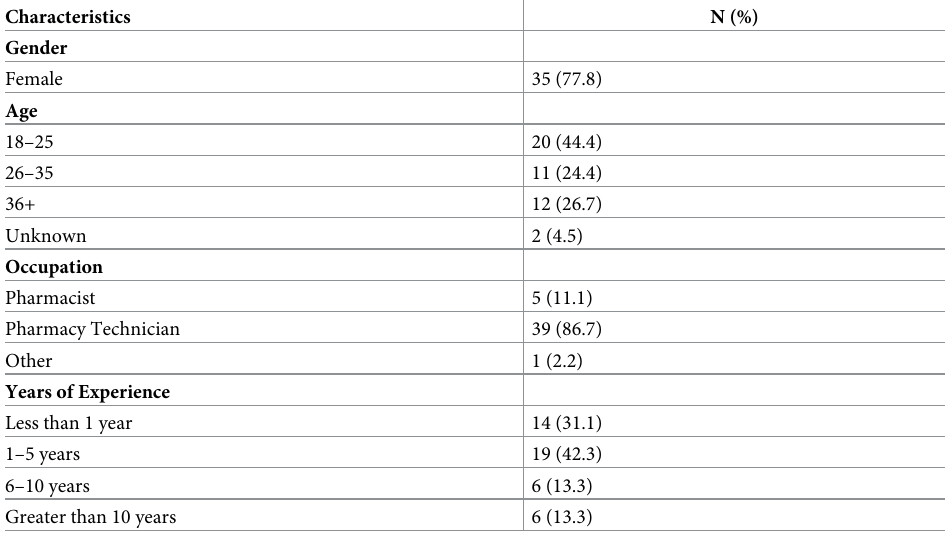
Table 1. Participants’ demographic characteristics, pharmacy workers, El Agustino, Lima, Peru (N = 45).